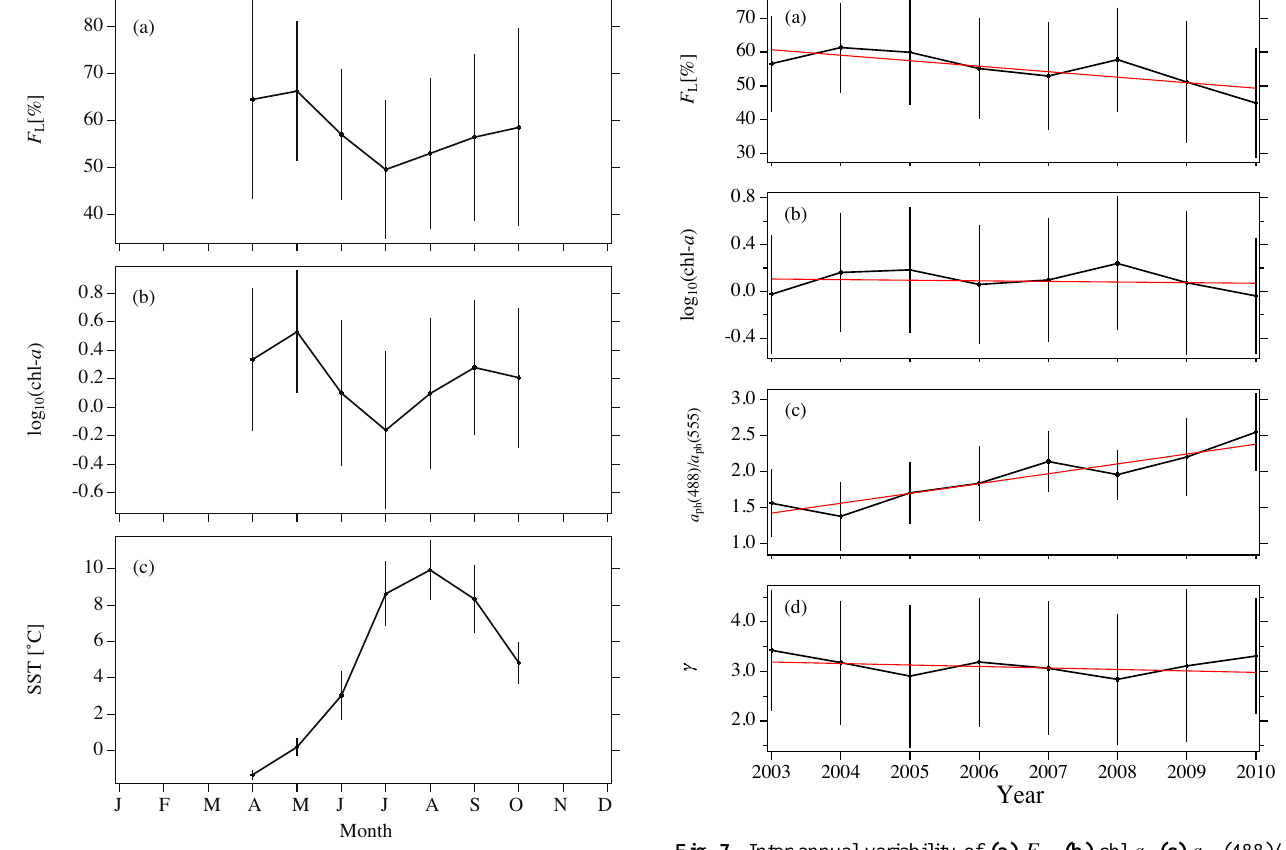
Fig. 6. Seasonal variability of (a) F L , (b) chl- a and (c) SST in the box-averaged area (60–72˚N, 166–172˚W) in 2007. Error bars indicate the standard deviation for each month. Seasonal variablility of F L and chl- a is highly correlated ( r = 0.92, p -value < 0.001). There is no valid data in the area between November and March beacuse of the presence of sea ice and cloud cover.